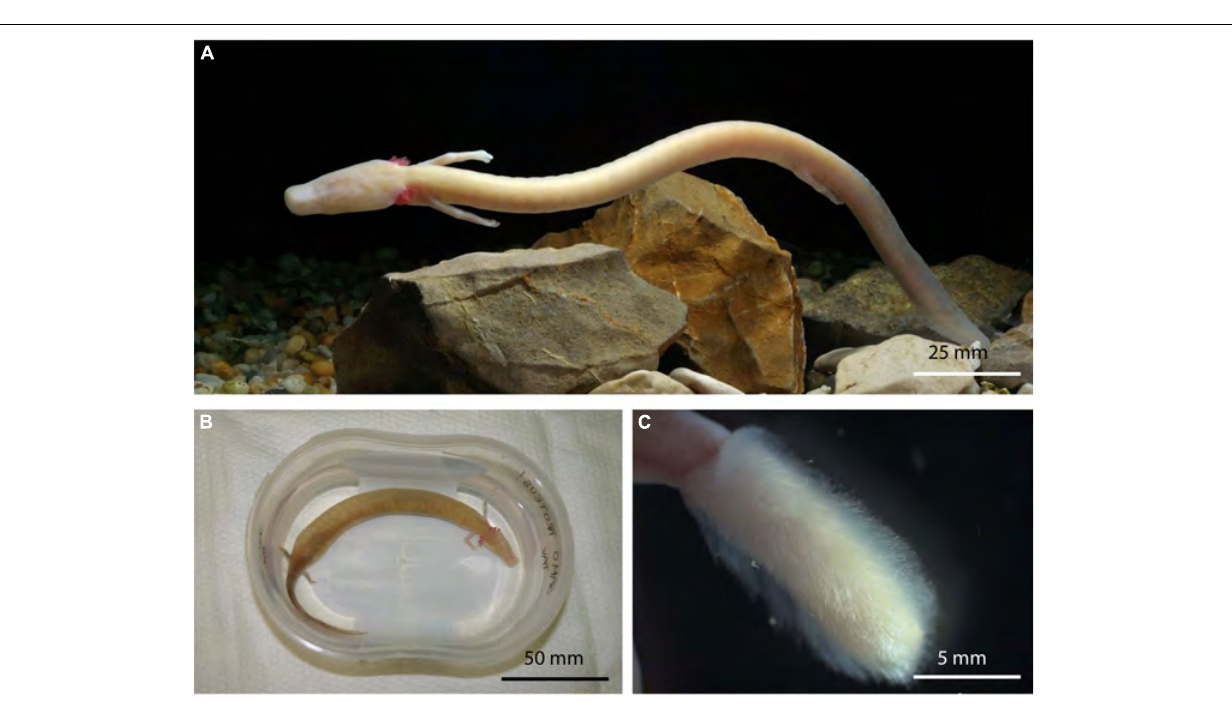
FIGURE 4 | Healthy asymptomatic olm, Proteus anguinus from captivity (A) . Specimen Paa23 with extensive edema throughout body cavity (B) . Dense, boot-resembling Sporolegnia overgrowth on hind limb of symptomatic animal Paa22 (C)